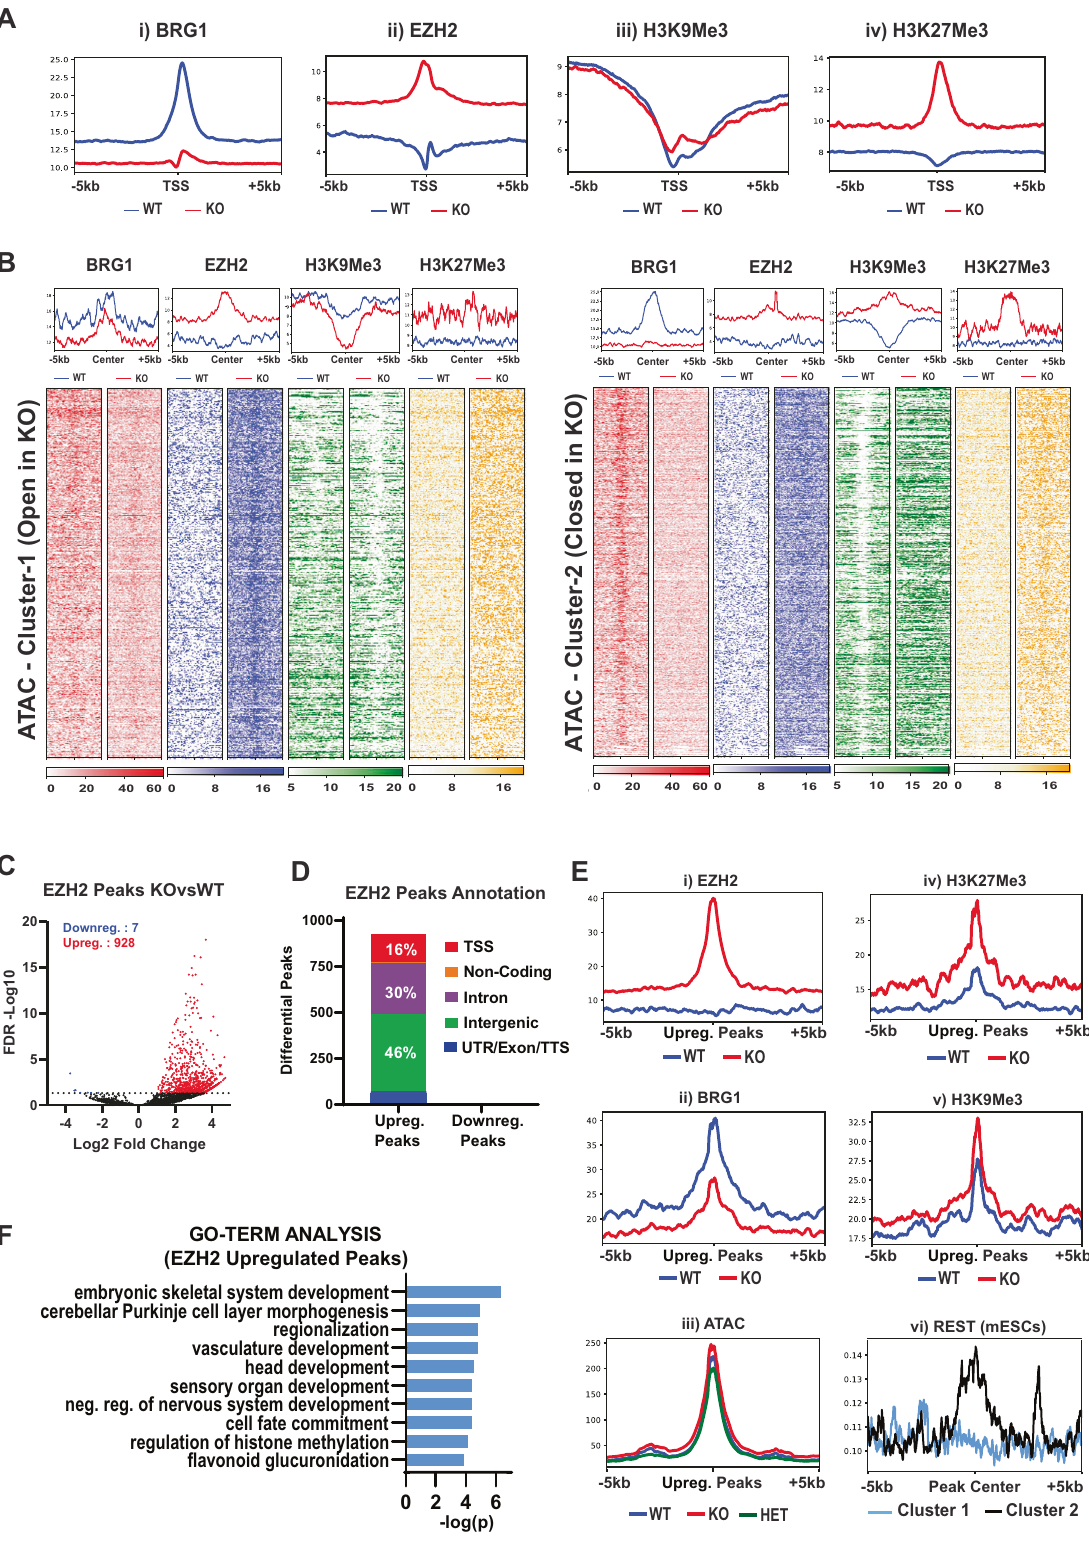
morphogenesisembryonic skeletal system development developmentregionalizationcerebellar Purkinje cell layer methylationcell fate glucuronidationregulation of histone flavonoid regions did not show an overall change in ATAC-Seq signal (Fig. 2E-iii), suggesting that the presence of EZH2 alone is not suf fi cient for inducing loss of chromatin accessibility. This result is consistent with a recent study showing that while loss of BAF activity leads to increased EZH2 recruitment, this only induces repression at a subset of genes where EZH2 colocalizes